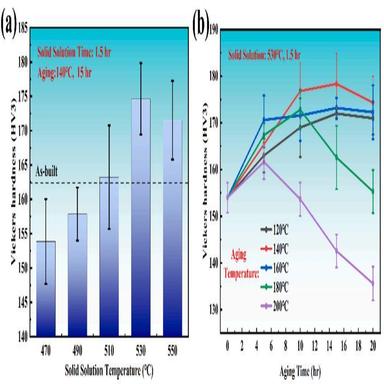
Vickers hardness of T6 heat treated 2024-5 vol% TiCN as the function of (a) solid solution temperature, and (b) artificial aging time.